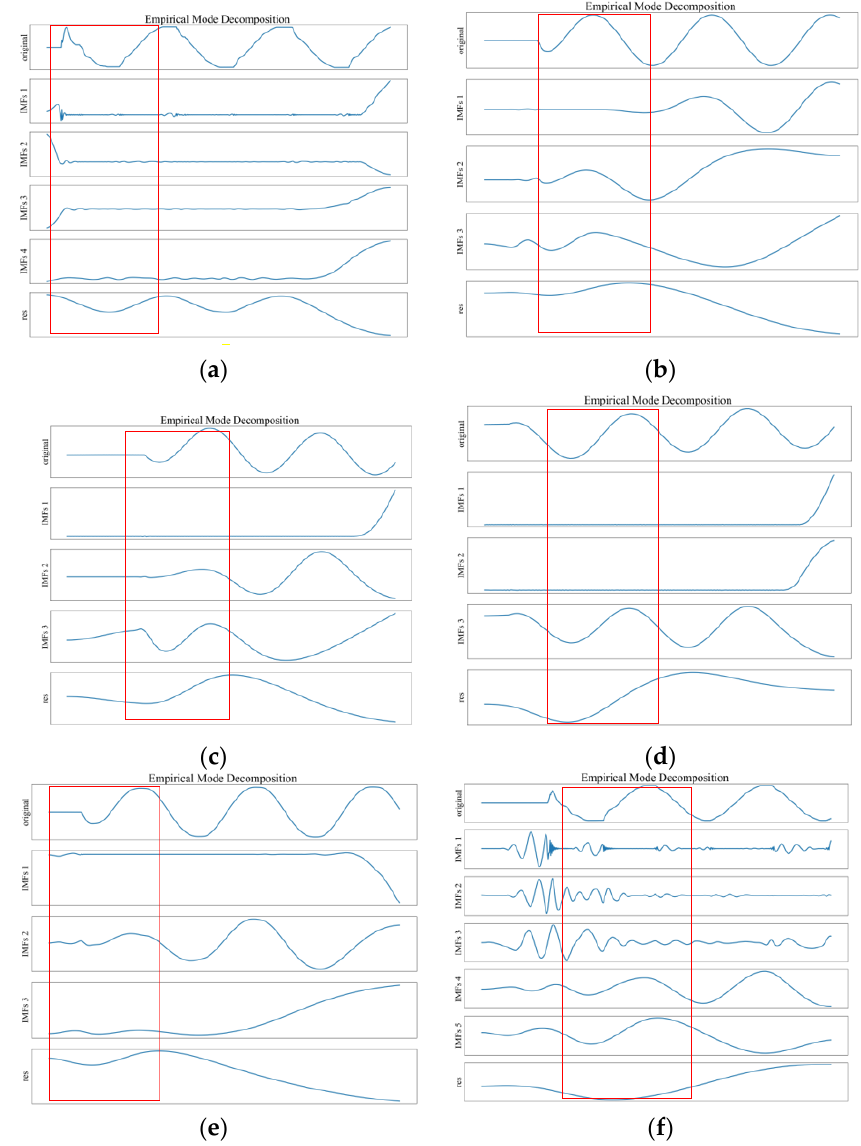
Figure 8. Comparison of empirical mode decomposition results.